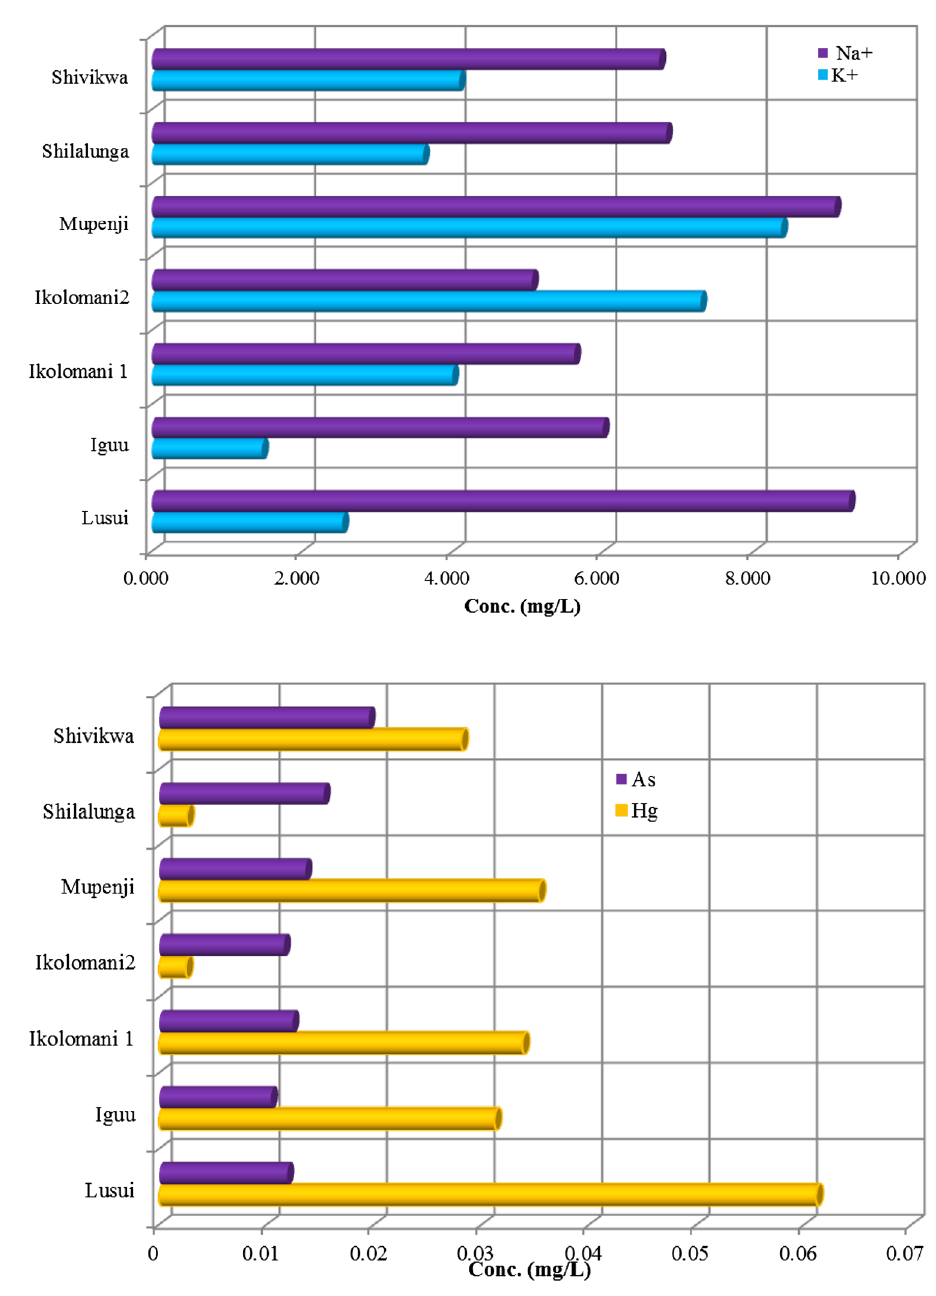
Fig. 2 The concentrations of sodium and potassium in the bore-hole waters of Kakamega County